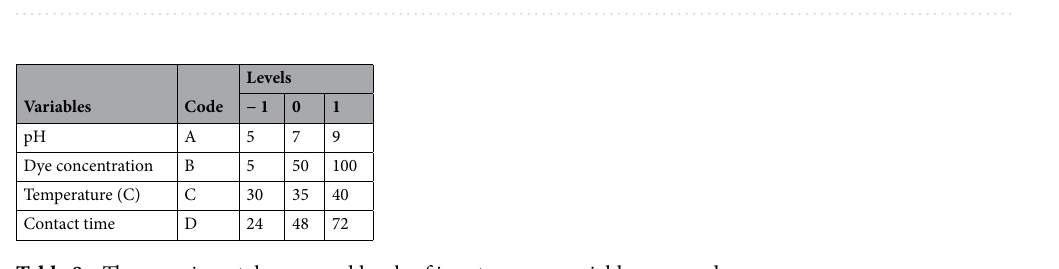
Figure 19. Temkin ( a ) nano bentonite and ( b ) MgO impregnated clay plots for adsorption of MG.